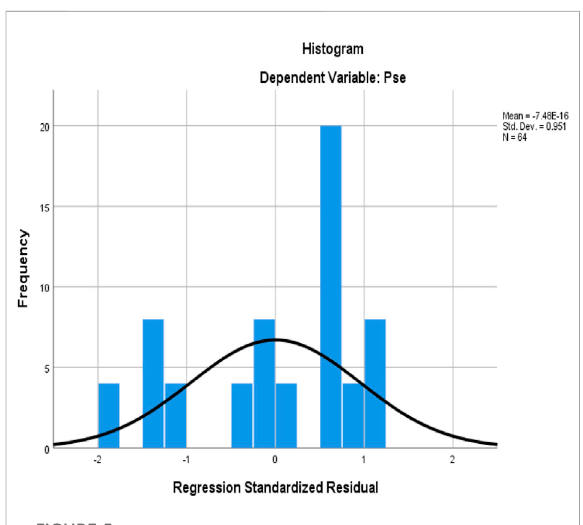
FIGURE 5 Histogram corresponding to the Pse dependent